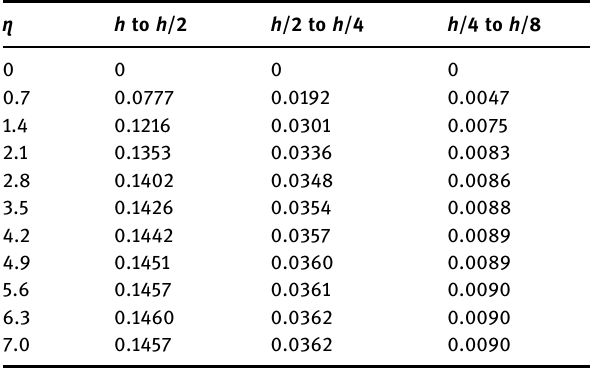
Table 5: Change in error for ( ) f η with step - size η